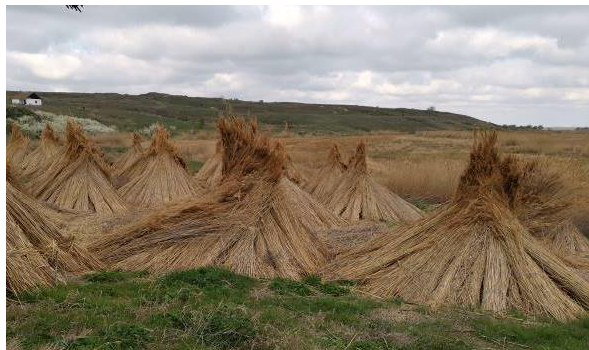
Figure 3. Reeds, harvested from the Razim lagoon banks.